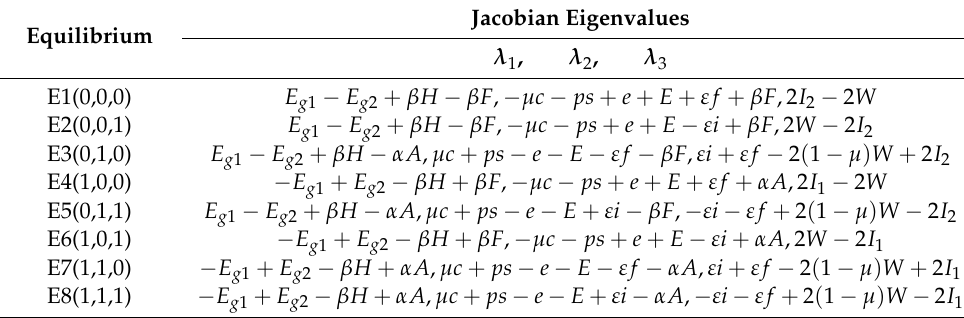
Table 2. Stability of equilibrium